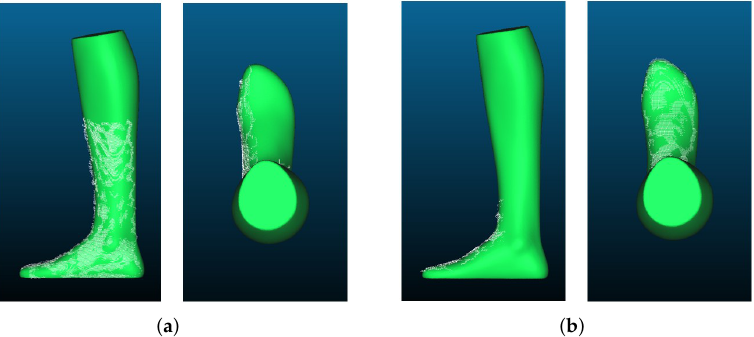
Figure 15. Point clouds recorded with Intel RealSense D455 placed over the GT: ( a ) length reconstruc- tion; ( b ) width reconstruction.